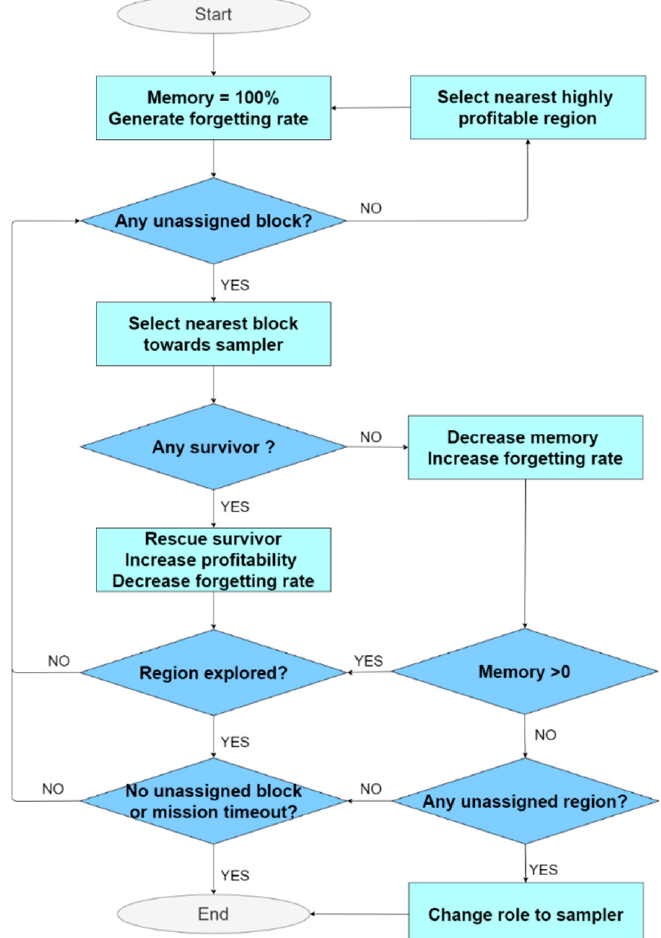
Figure 4. Follower algorithm.